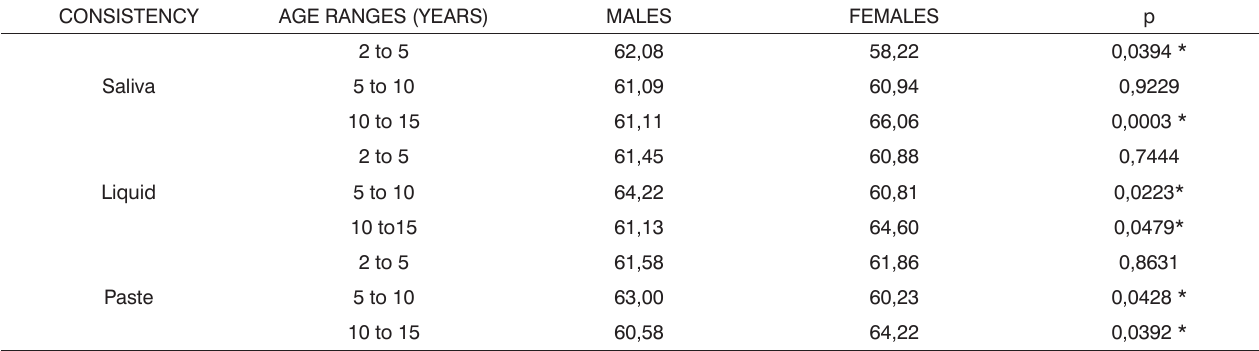
Table 3. Mean values and results from the initial intensity comparison tests according to gender.